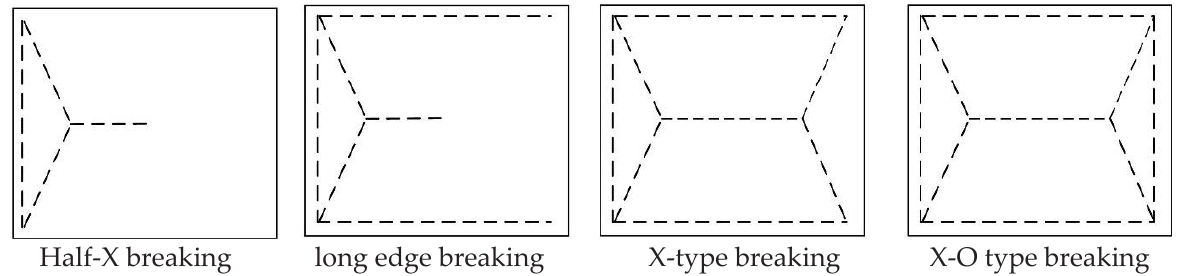
Figure 12. Roof X-O type breaking evolution process.